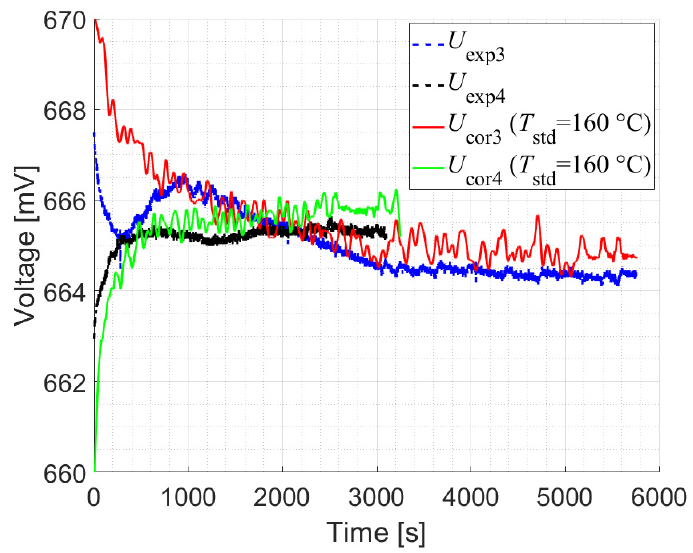
Figure 11. Application of the readjustment methodology for the temperature to the voltage from Figure 3. The corrected voltages U Cor3 and U Cor4 are given at a standard temperature of 160 ◦